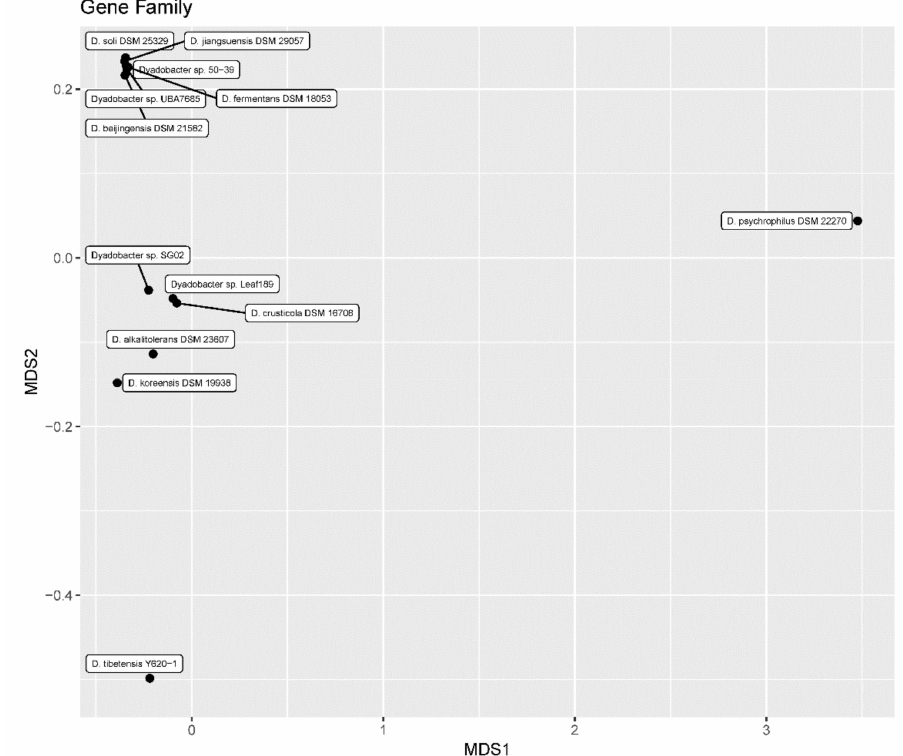
Figure 3. Nonmetric multidimensional scaling (NMDS) plot of gene family showing clear separation of the two cold adapted strains D. tibetensis Y620-1 and D. psychrophilus DSM